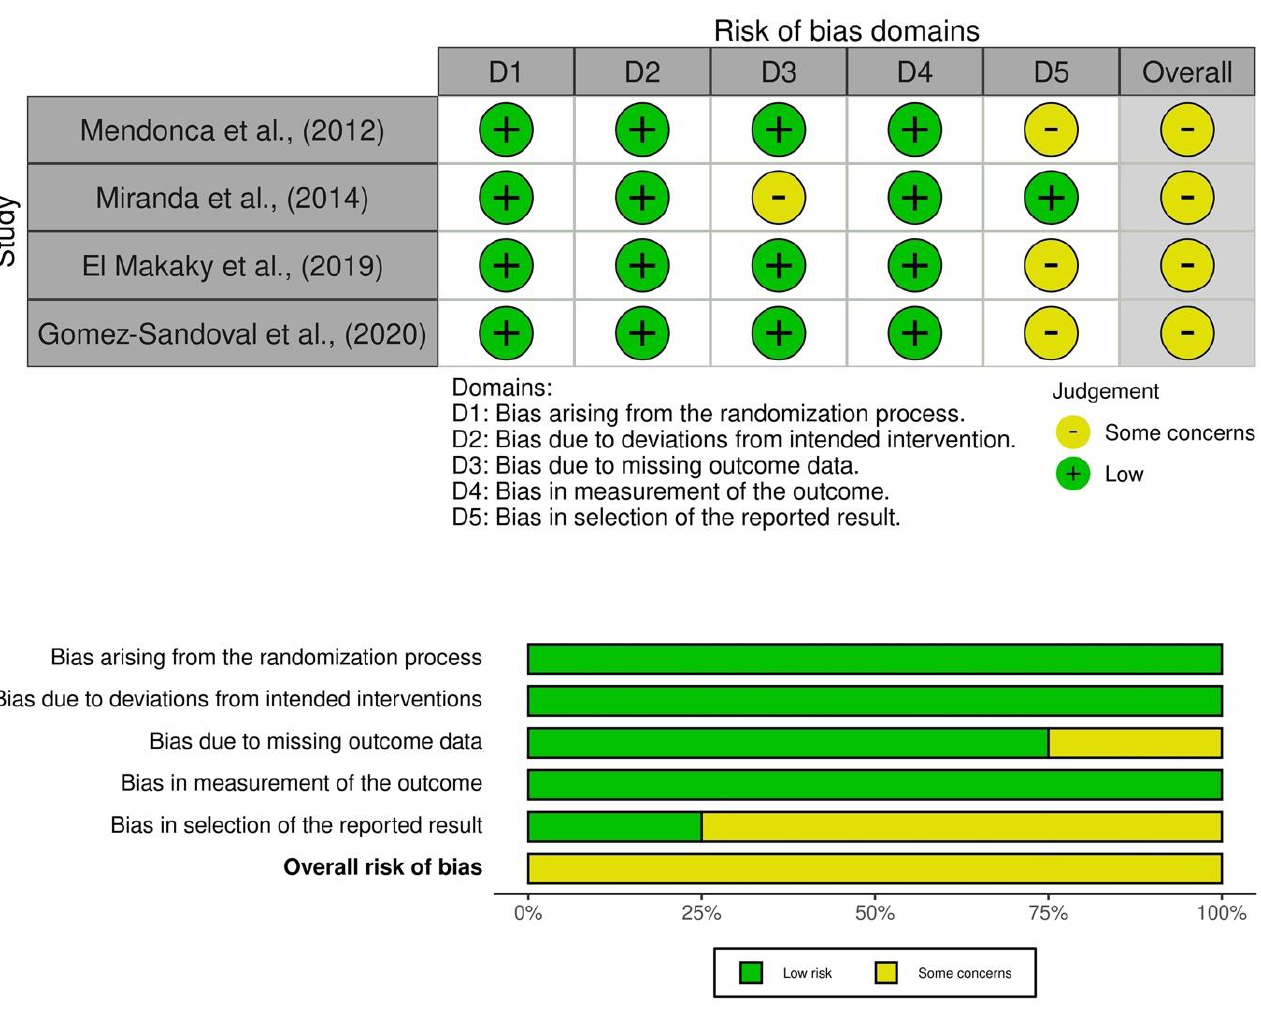
Figure 2. Summary of the risk of bias [28 − 31].